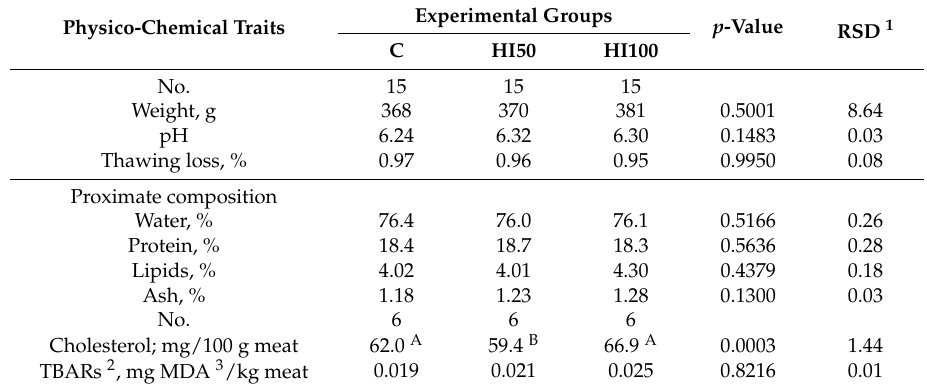
Table 2. Physico-chemical quality of the breast meat of chickens fed with 0% (C), 50% (HI50) and 100% (HI100) substitution of soybean oil with Hermetia illucens (HI) larvae fat in their finisher